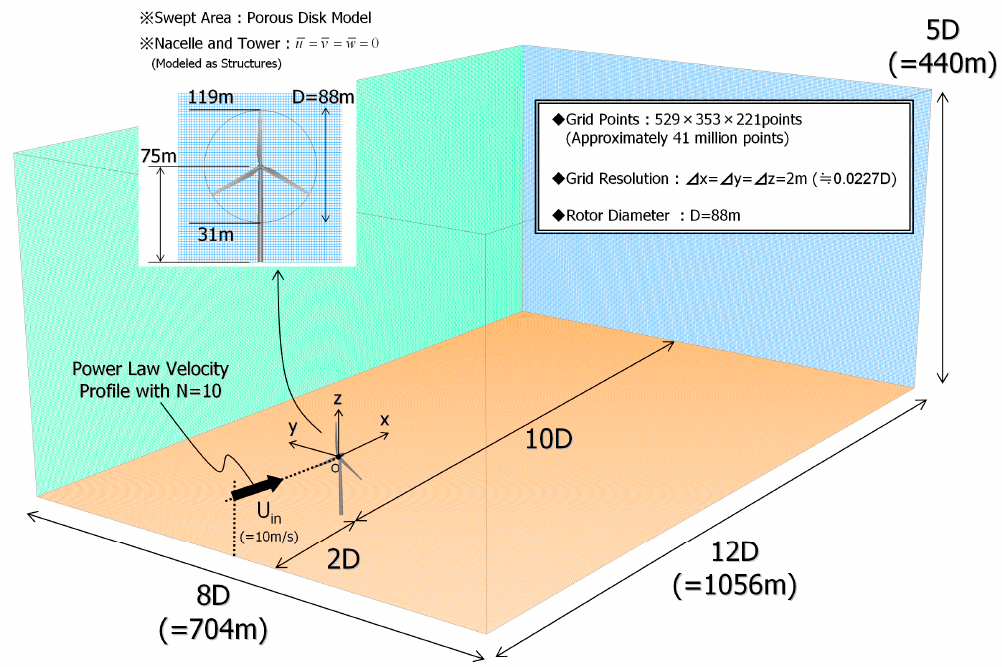
Figure 17. Computational domain and computational grid in the case of LES using the CFD PD wake model.